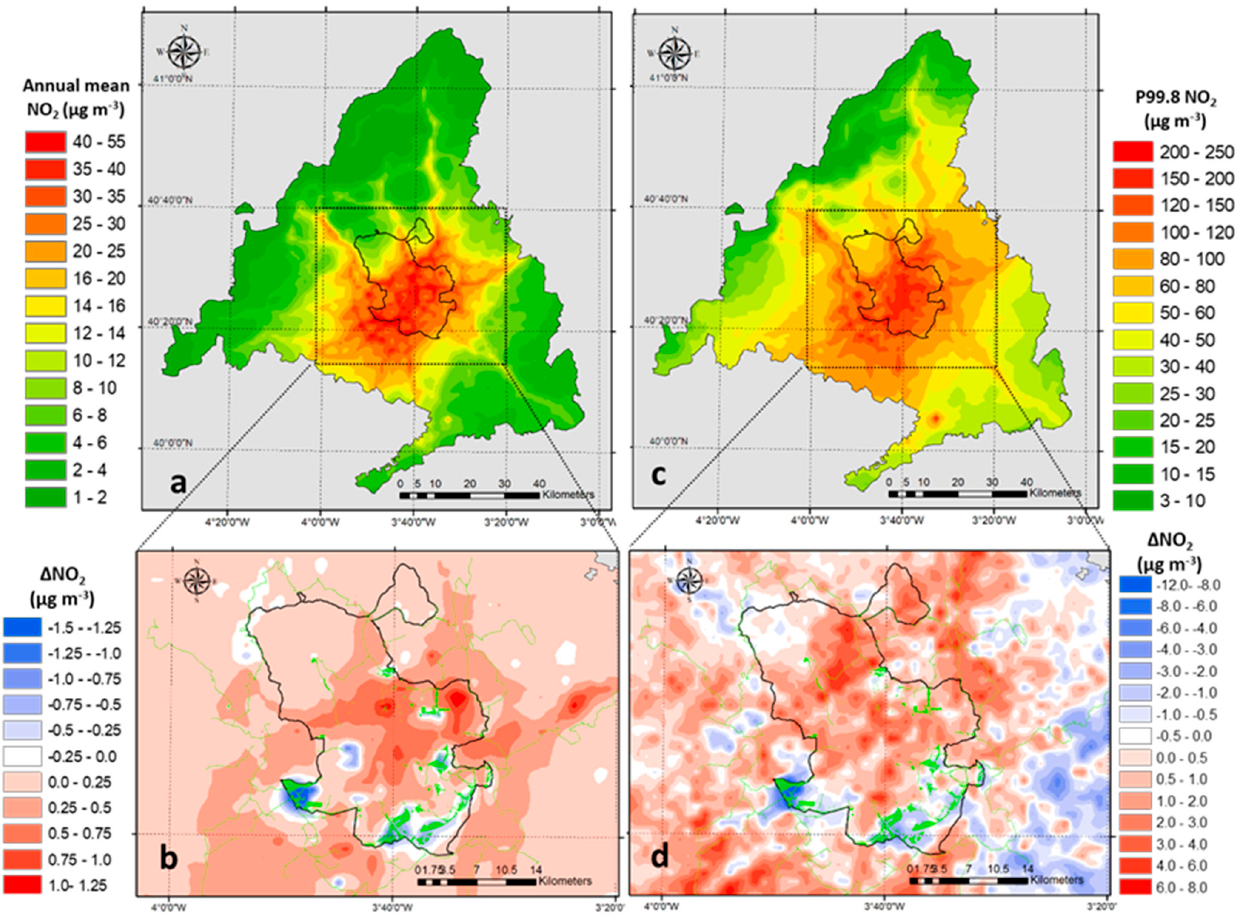
Figure 7. Annual mean of NO 2 (µg m − 3 ) for the Baseline Scenario ( a ) and expected variation (µg m − 3 ) due to future vegetation ( b ). Hourly 99.8 NO 2 percentile (µg m − 3 ) for the Baseline Scenario ( c ) and expected variation (µg m − 3 ) due to future vegetation ( d ). Table 3. Summary of the effect of NBS on air pollution (relative change in brackets).